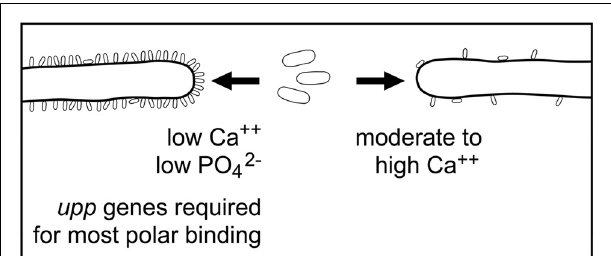
FIGURE 3 |A model of the initial binding of A. tumefaciens to root hairs. In the presence of low levels of calcium UPP is formed and mediates polar bacterial attachment to the root hair surface.This results in binding of large numbers of bacteria to the root hair.The genes for synthesizing the UPP are required for this binding. In the presence of moderate or high levels of calcium UPP is not formed and bacterial binding is